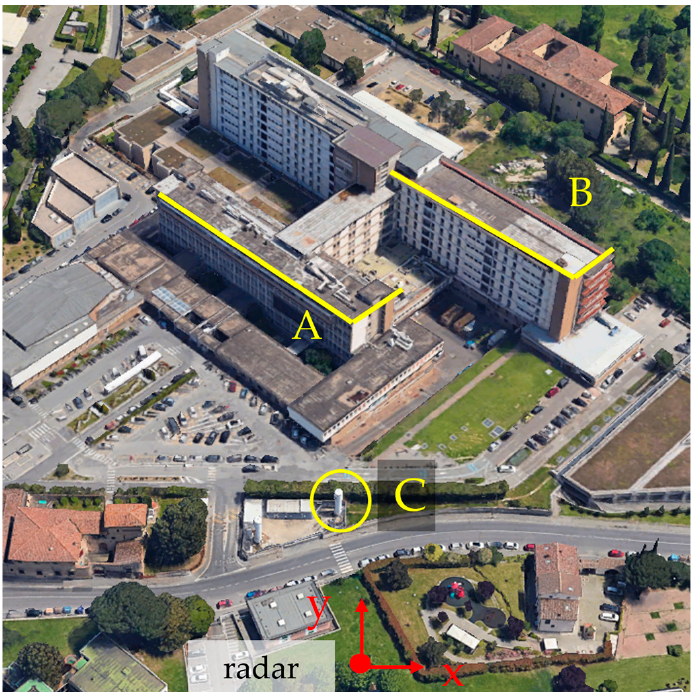
Figure 10. Aerial view of the illuminated area. The radar position is highlighted by the red dot. The main targets present in the scene are highlighted in yellow. A is the upper edge of the closest building, B is the upper edge of the farthest building on the right, C is a metallic tank with industrial gas.